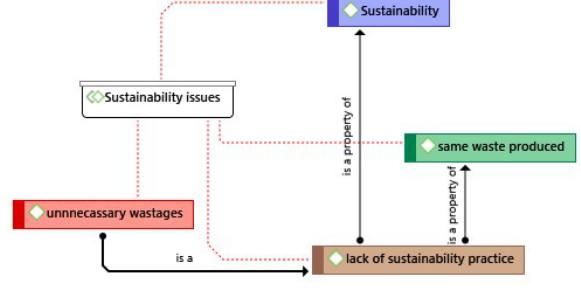
Fig. 8. Theme 5 (sustainability issues)